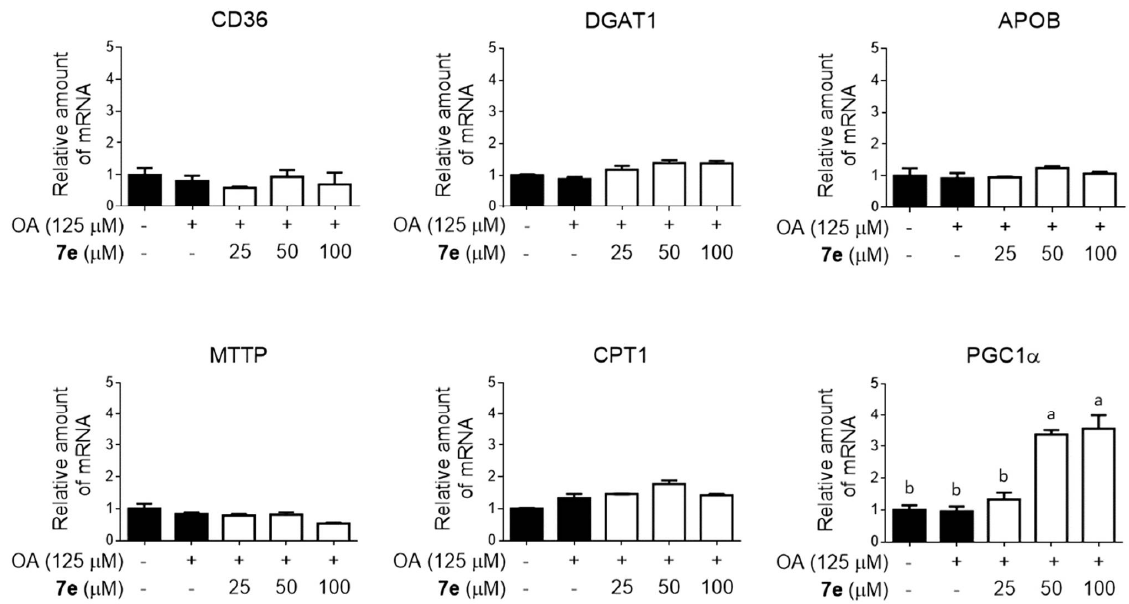
Figure 3. The effects of 7e on lipid metabolism gene expression. Huh7 cells were treated with either bovine serum albumin (BSA) or BSA-conjugated oleic acid (OA) (125 mM) with the indicated concentrations of 7e for 16 h. RT-qPCR was used to determine the expression profile of lipid metabolism-associated genes: Lipid entry, CD36; TG formation, DGAT1; β-oxidation, CPT1; lipid secretion, APOB and MTTP; and mitochondria biogenesis, PGC1α. Statistical analysis was performed using ANOVA, and different superscript letters (a and b) indicate statistically significant differences ( p < 0.05).